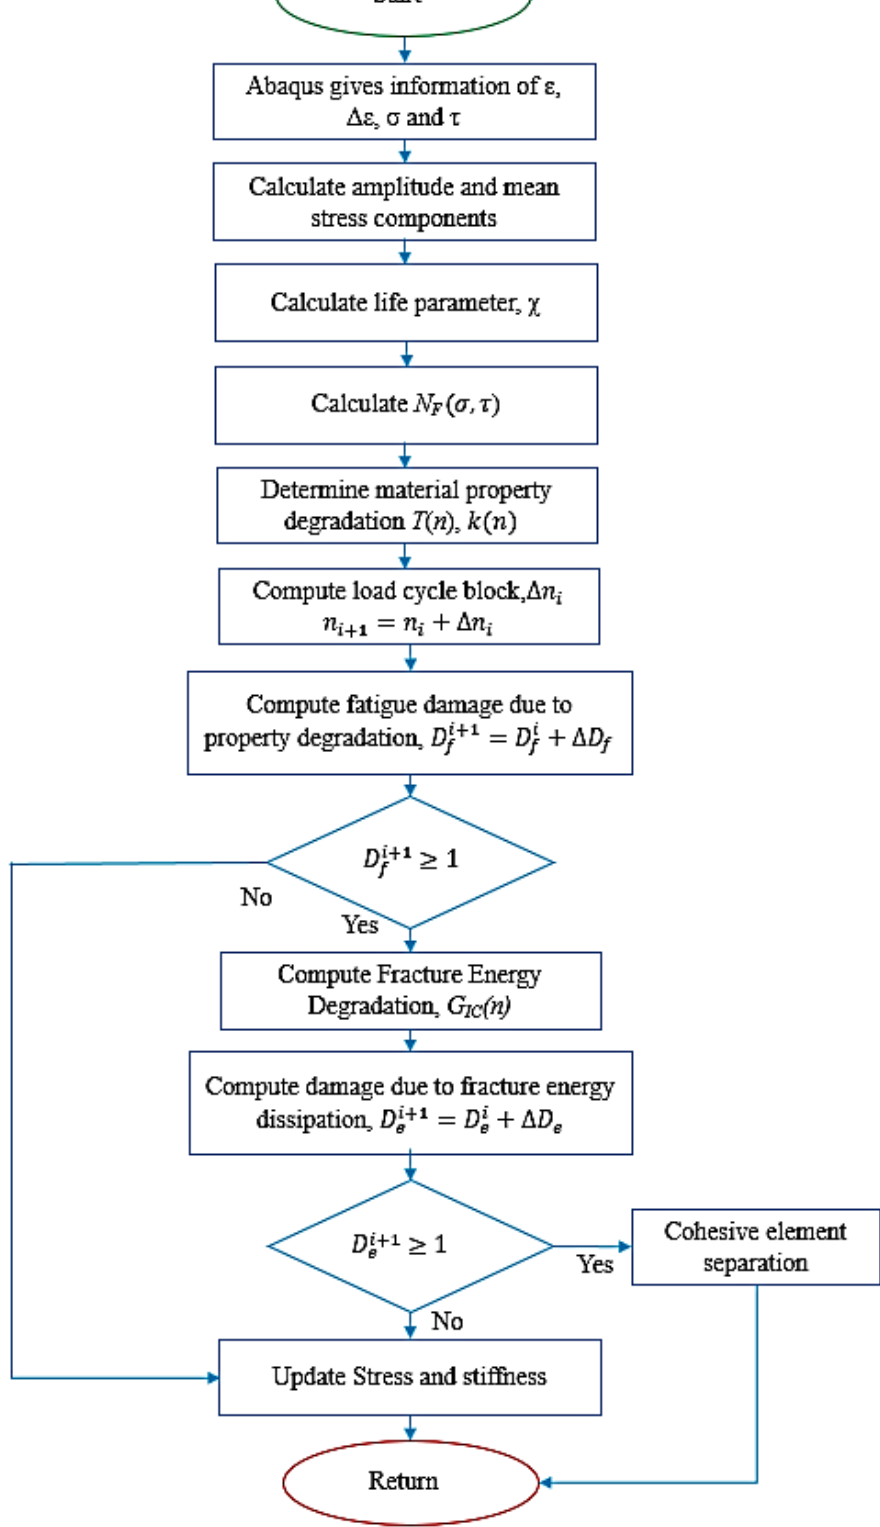
Figure 5. Flowchart of the interlaminar fatigue damage model for the user-defined subroutine UMAT.